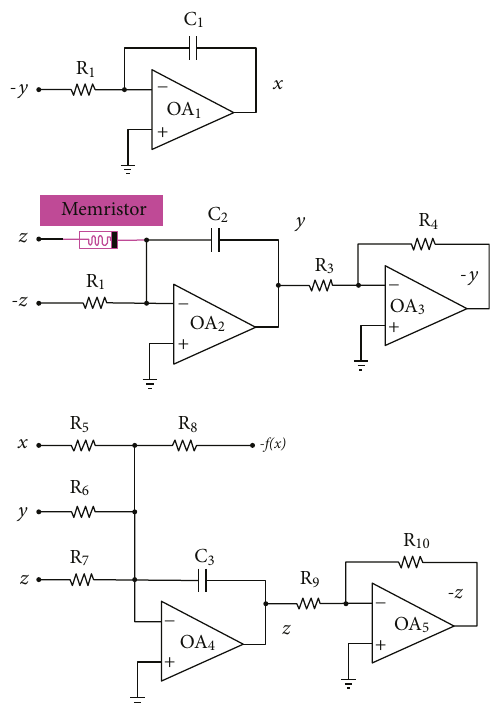
Figure 10: Proposed scroll-controllable hyperchaotic